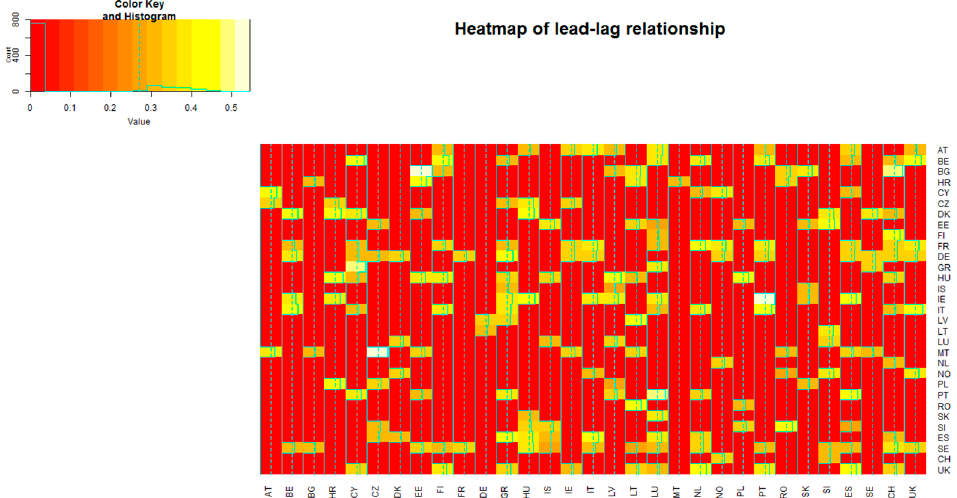
Figure 4. Heatmap of the lead-lag relationships.